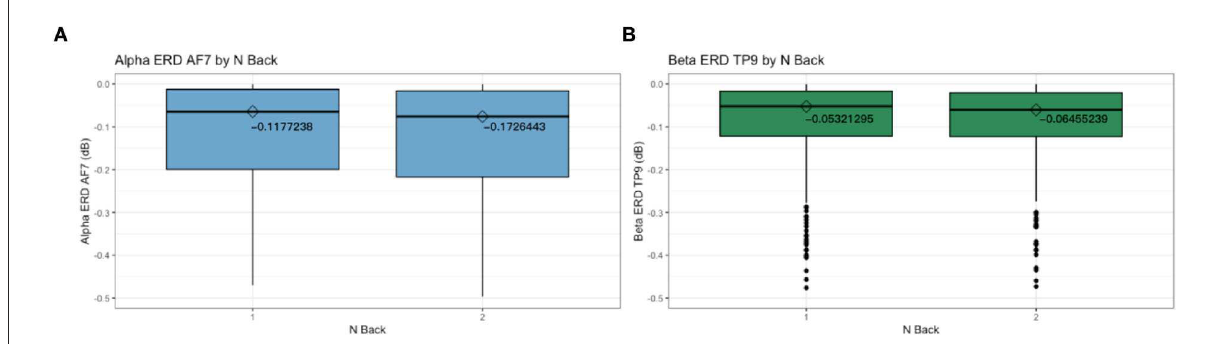
FIGURE5 Box plots with medians between 1 back and 2 back for Alpha ERD AF7 (A) and Beta ERD TP9 (B)